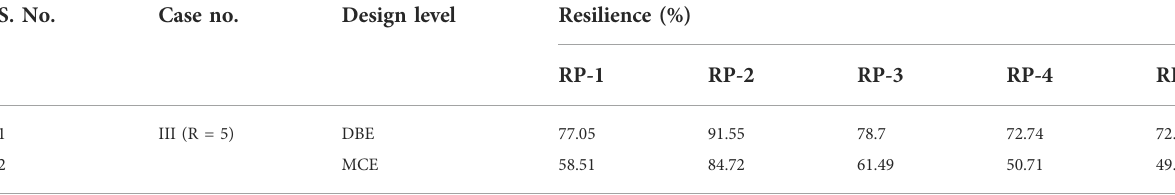
TABLE 11 Variation in resilience at each design level for case III building. S. No.